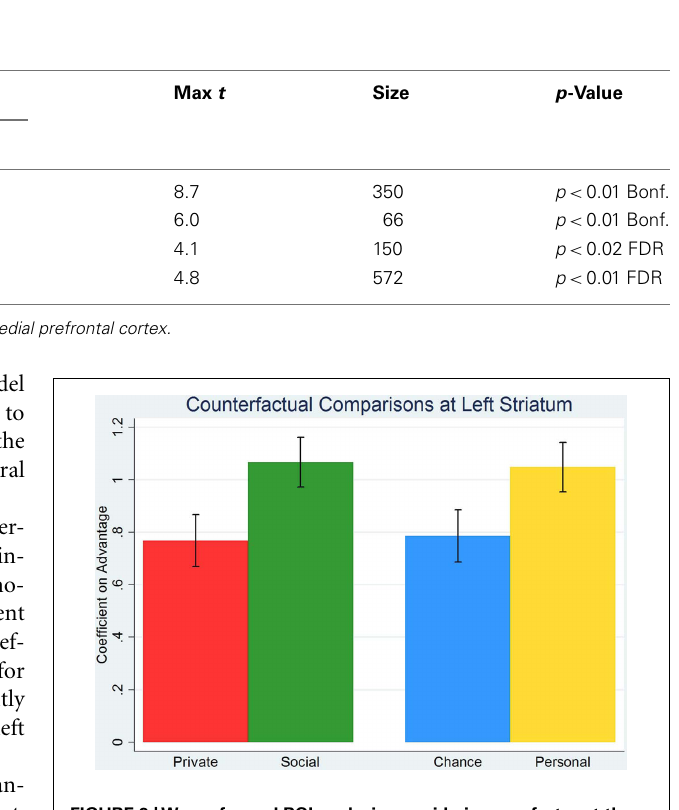
FIGURE 3 |We performed ROI analysis, considering one factor at the time, on the cluster of left ventral striatum, identified earlier as a part of universal network for counterfactuals, showing that coefficients on linear predictors in advantage are positive in all treatments. The coefficient on advantage is larger in social than in private environment and with personal than with chance